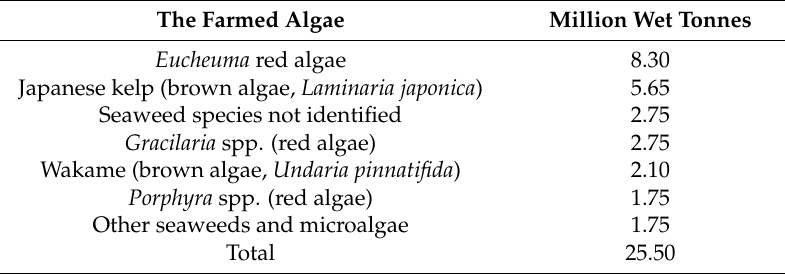
Table 2. Categorization of the farmed